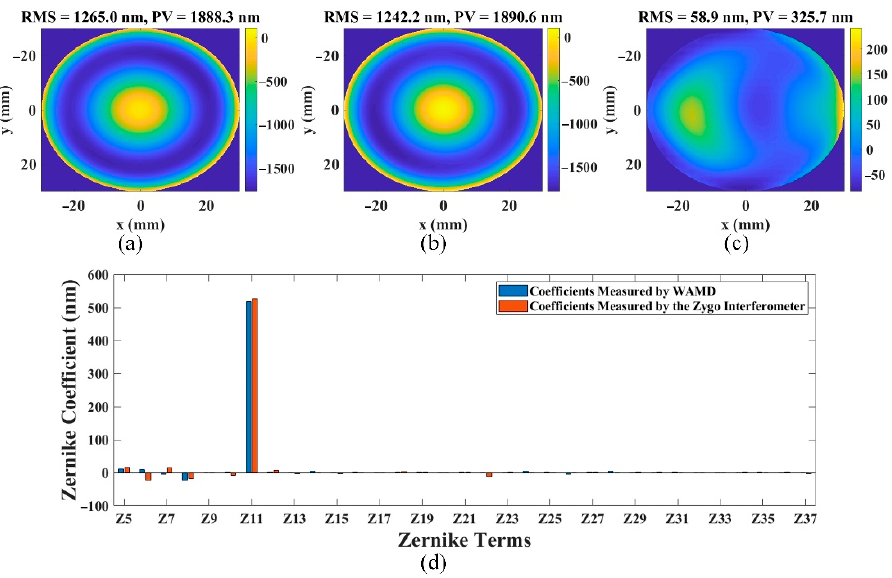
Figure 8. Wavefront aberration of the plano-convex lens in the experiment: ( a ) measured by WAMD; ( b ) measured by a Zygo interferometer; ( c ) difference between ( a , b ); ( d ) comparison of Zernike co- efficients.